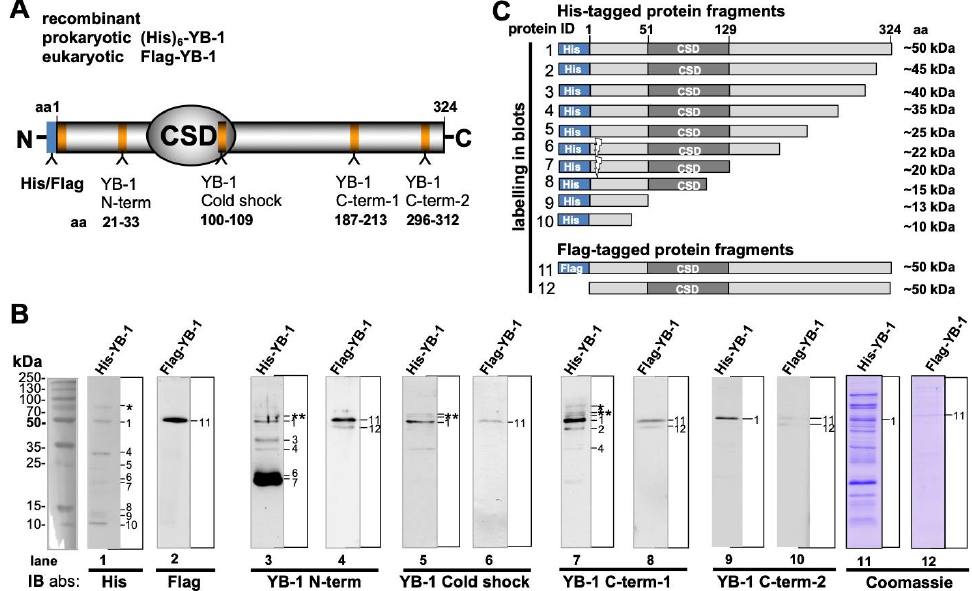
Figure1. RecombinantYB-1proteinexpressionandspontaneouscleavage. ( A )Schematicrepresentation Figure 1. Recombinant YB-1 protein expression and spontaneous cleavage. ( A ) Schematic of recombinant His / Flag YB-1 protein with its N-terminus, C-terminus, and centrally localized cold shock representation of recombinant His/Flag YB-1 protein with its N-terminus, C-terminus, and centrally domain. His- and Flag-tags are both located at the N-terminal ending. Locations of peptide epitope used for the immunization of rabbits to obtain polyclonal, a ffi nity-purified antibodies are indicated. The nomenclature used is N-term, Cold shock, C-term-1, and C-term-2. ( B ) Immunoblotting and detection of recombinant His- (2.5 µ g) and Flag (1.5 µ g)-tagged YB-1 proteins with monoclonal anti-His and anti-Flag antibody, polyclonal anti-YB-1 antibodies, and Coomassie staining by 50 kDa. His-YB-1 presents several fragments reaching from 10 to 40 kDa. Flag-YB-1 presents only 1 additional band of 45 kDa relative molecular size. All antibodies are able to detect YB-1 full-length protein at the reported relative molecular weight of 52 kDa. Prokaryotic His-YB-1 degrades into several fragments (denoted 3 through 10), whereas eukaryotic Flag-YB-1 seems to be more stable and exhibits only one additional protein fragment at around 48 kDa (indicated by < 2). There are two strong bands for His-YB-1 at 18–22 kDa detected with anti-N-term Ab only. Possibly these are co-purified protein fragments enriched by the Ni-column a ffi nity process that is devoid of the His-tag at the terminal end. The corresponding band with anti-His antibody is very weak (indicated by > 6 and > 7). Notably, with prokaryotic His-YB-1, there are also bands detected at 56, 58, and 70 kDa (indicated by * and **), thus exceeding the reported relative molecular weight of YB-1 protein. Likely, these are aggregates of YB-1 protein derivatives that are not discernible by the SDS-PAGE procedure. ( C ) A schematic His- / Flag-YB-1 protein cleavage pattern was a set-up from the immunoblotting results. Full-length His-YB-1 (indicated by < 1)